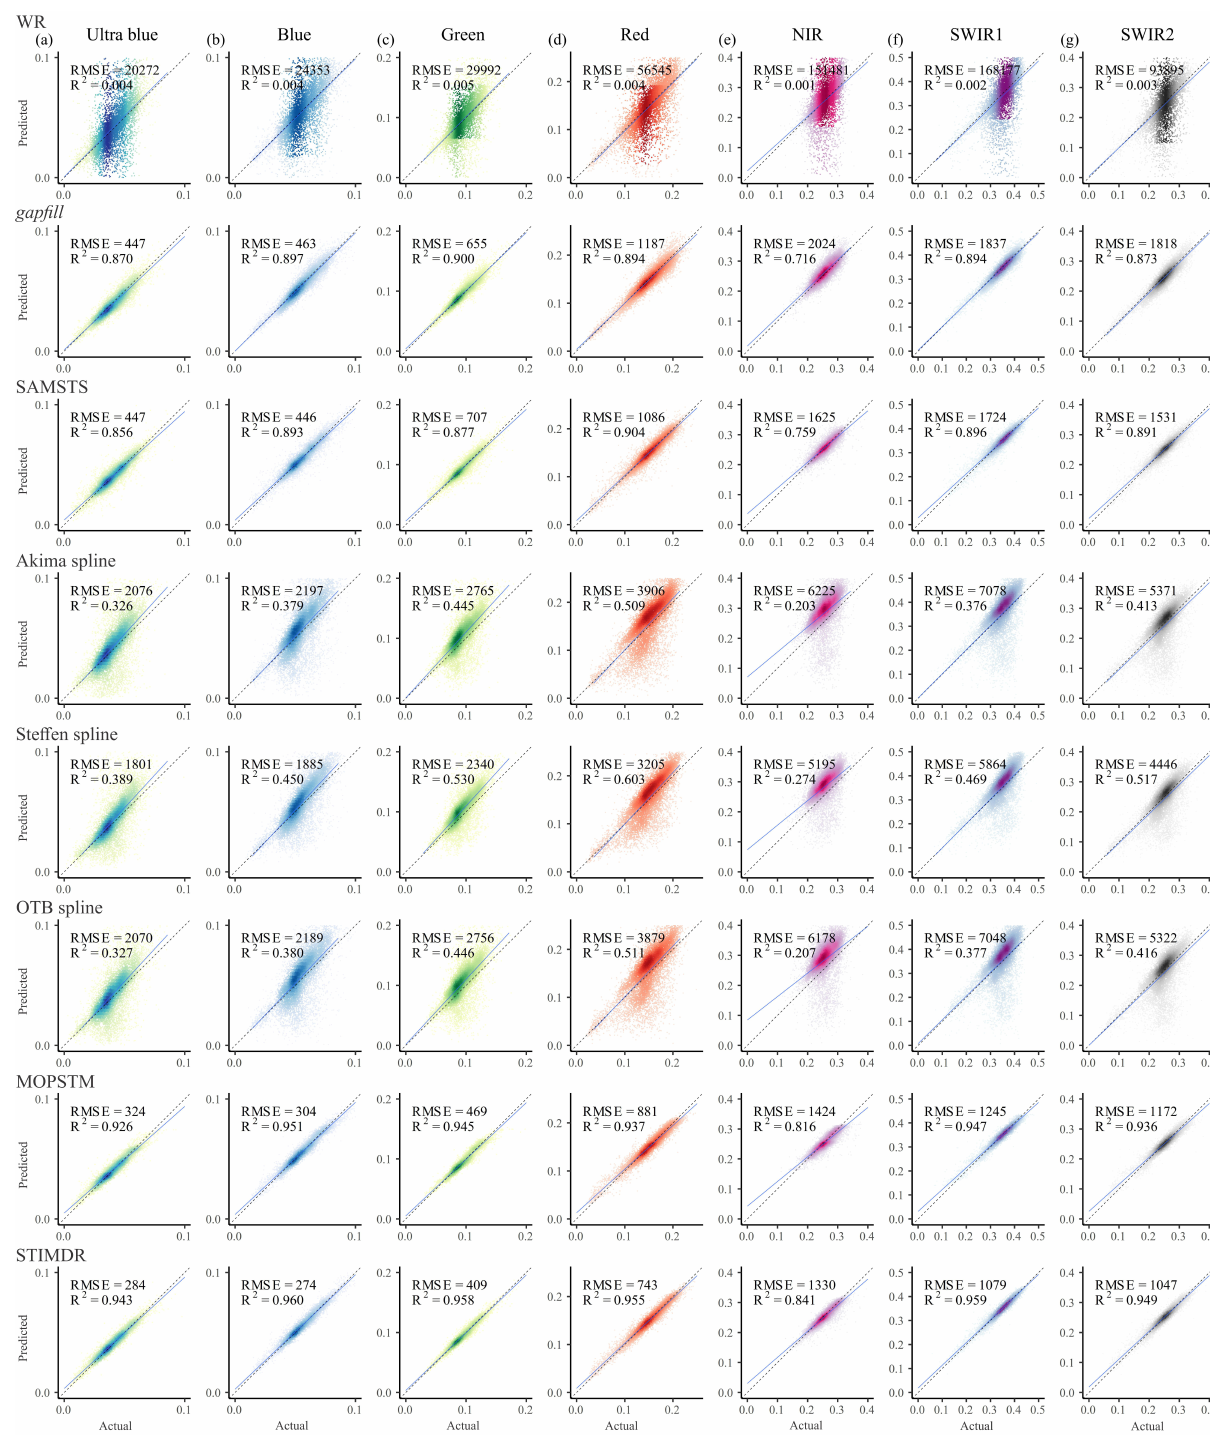
Figure 9. Density scatter plot of WR, gapfill , SAMSTS, Akima spline, Steffen spline, OTB spline, MOPSTM, and STIMDR predicted values ( y -axis) and referenced values ( x -axis) for seven spectral bands in Site 1. The black dashed line is the 1:1 line, and the solid blue lines indicate the linear regression fits. Darker color shading: regions with a large density of points; lighter color shading: regions with a small density of points. RMSE was multiplied by 100,000. All pixels are from the common reconstructed